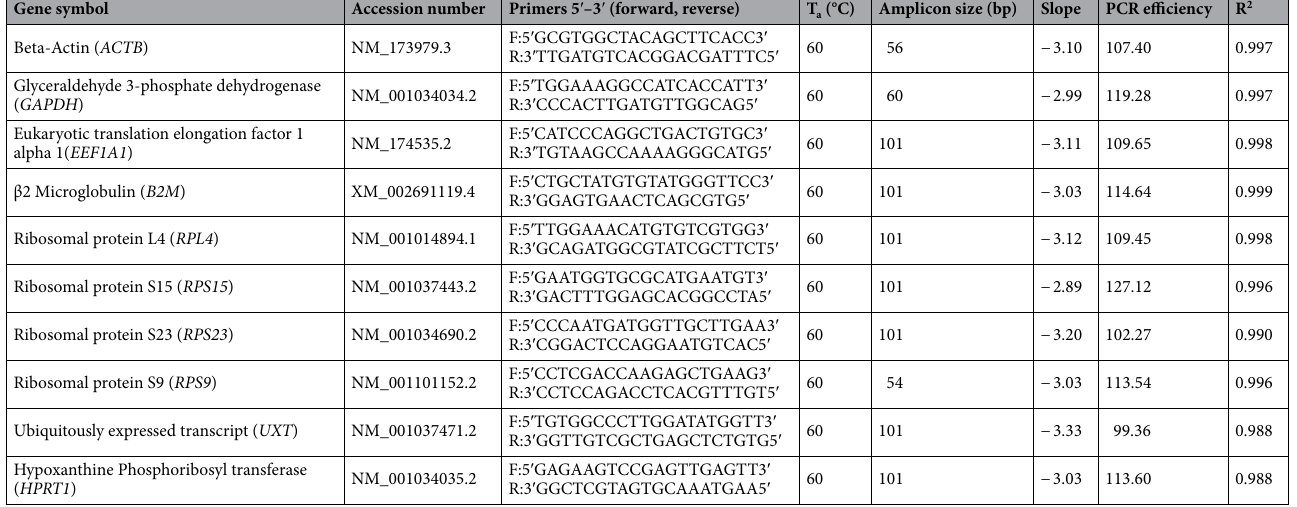
Table 1. Gene symbol, accession number, primer sequence, melting temperature (T a ), amplicon size, slope, PCR efficiency and R 2 of RGs for each evaluated